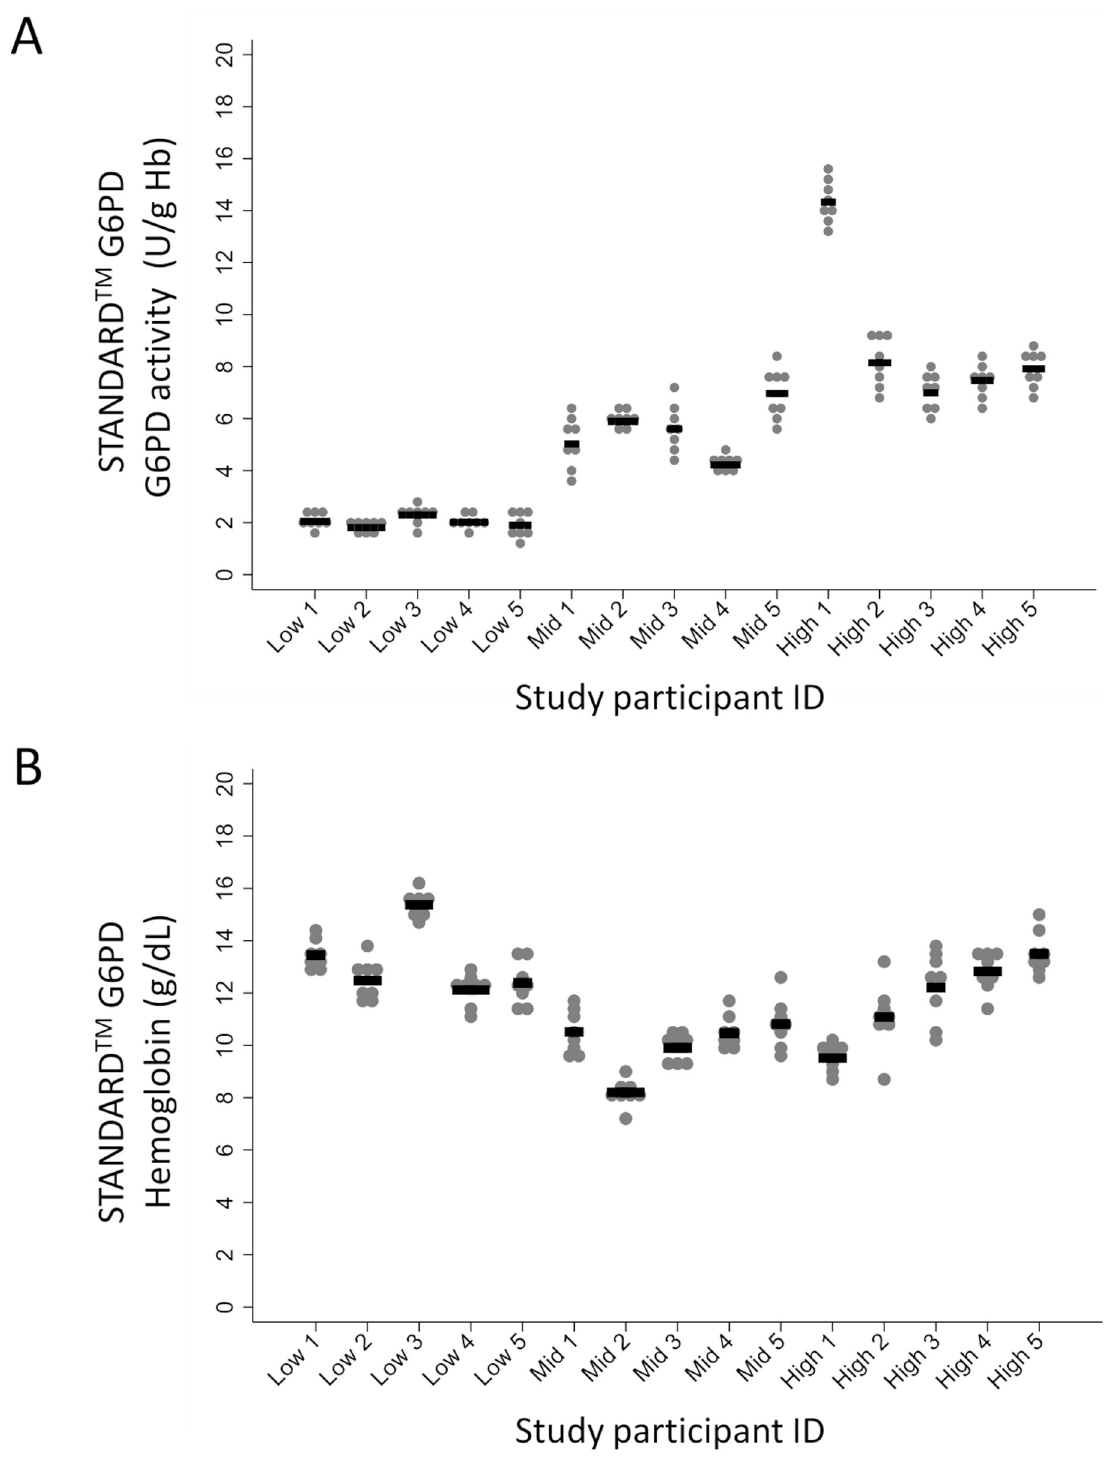
Fig 3. Fingerstick precision for the STANDARD G6PD Test. Fifteen study participants with G6PD deficient, intermediate, and normal activity on the STANDARD G6PD Test were tested on both hands by two operators across four fingers (two per hand), for a total of eight STANDARD G6PD Test runs. (A) STANDARD G6PD Test results per study participant. (B) Hemoglobin test results per study participant.